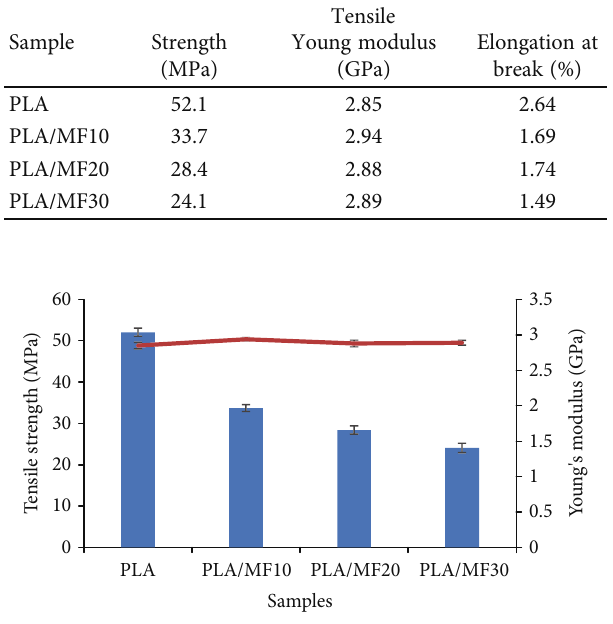
Figure 8: Tensile strength and modulus of PLA/MF composites. Table 5: Flexural properties of composite samples. Sample